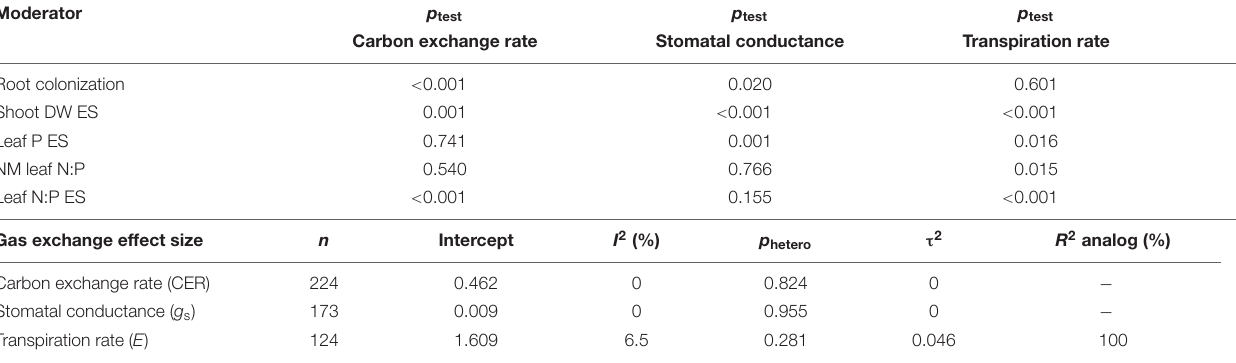
TABLE 4 | Multi-factor meta-regression of studies having data for each of the five regression